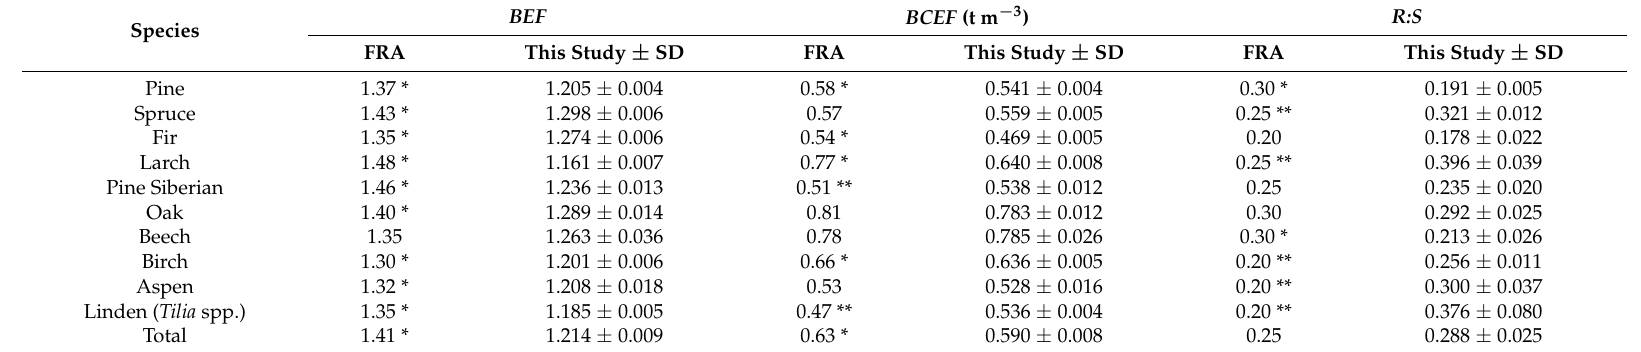
Table 4. Comparison of BEF, BCEF and R:S calculated using our approach with the FAO FRA country report [14].